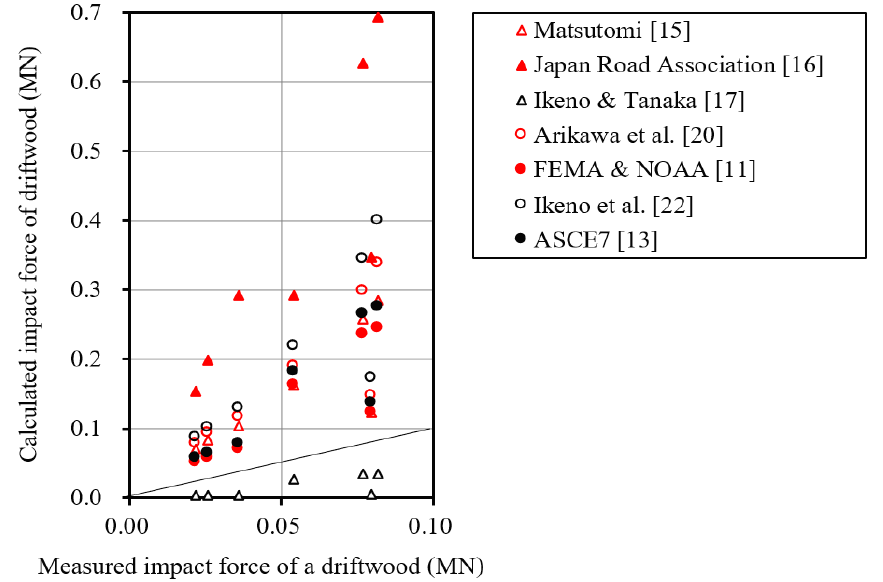
Figure 5. Comparison of impact forces for driftwood.